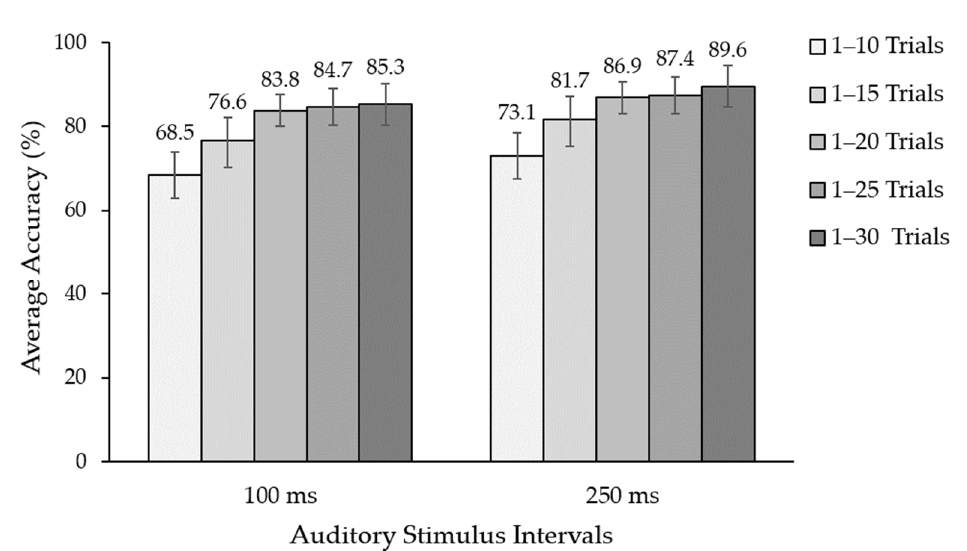
Figure 7. Average classification accuracy between 100 ms and 250 ms in the auditory stimulus intervals. Confidence interval (Alpha: 0.01). Table 5. Results of the average classification accuracy of different stimuli intervals (tone duration) of vowels and numerals for each